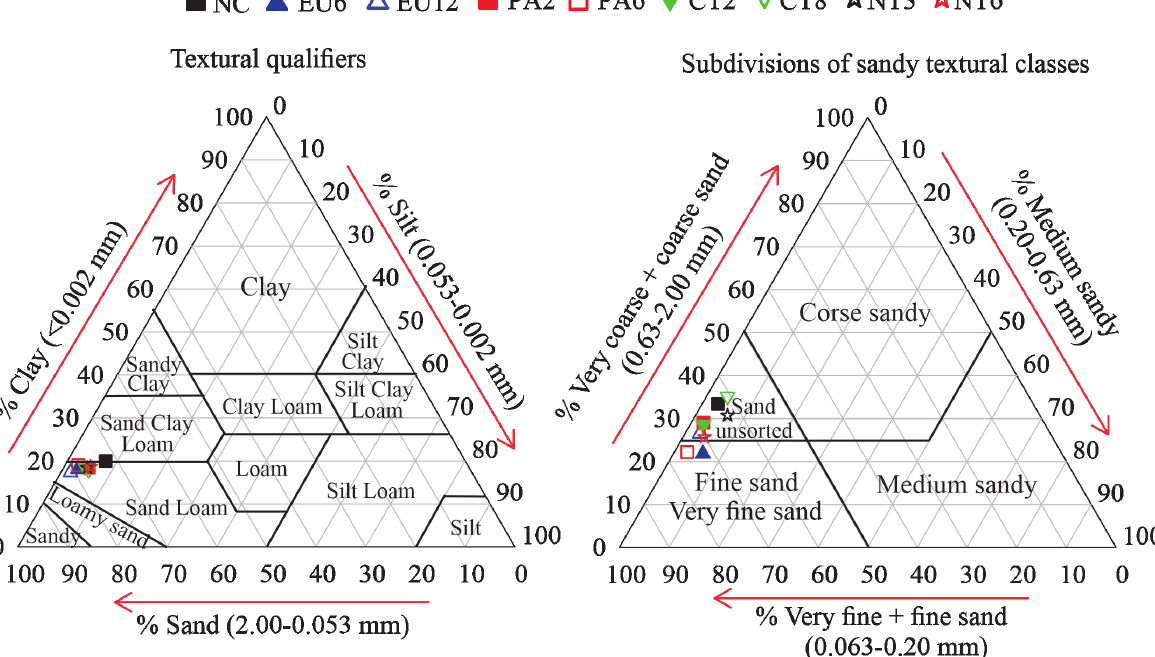
Figure 2. Soil textural classes and sand subdivision. Soil management systems: NC – Native Cerrado, EU6 – Six year Eucalyptus, EU6 - Twelve years Eucalyptus, PA2 – Pasture (two years), PA6 – Pasture (six years), CT2 – Conventional tillage (two years), CT8 – Conventional tillage (eight years), NT3 – No-tillage (three years), NT6 – No-tillage (six